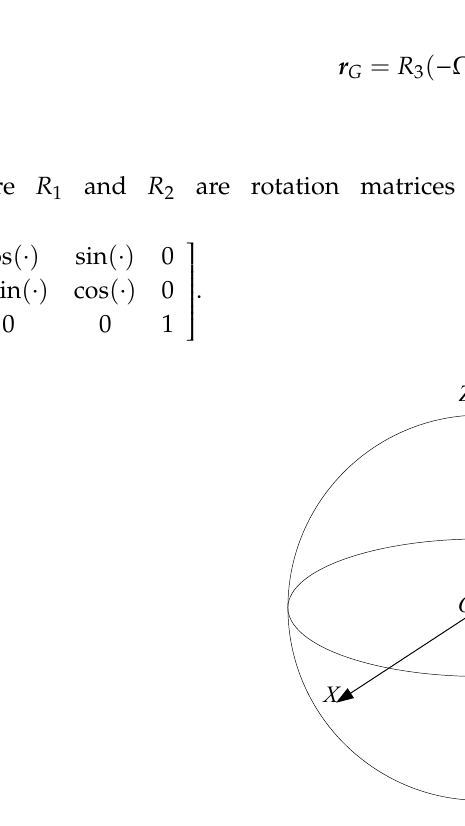
Figure 5. The sub-solar point. S’ is the sub-satellite point, which is defined as the intersection of the line connecting the satellite and the center of the Earth with the Earth’s surface. G is the sub-solar point. z represents the zenith distance between the sub-solar point and the sub-satellite point.